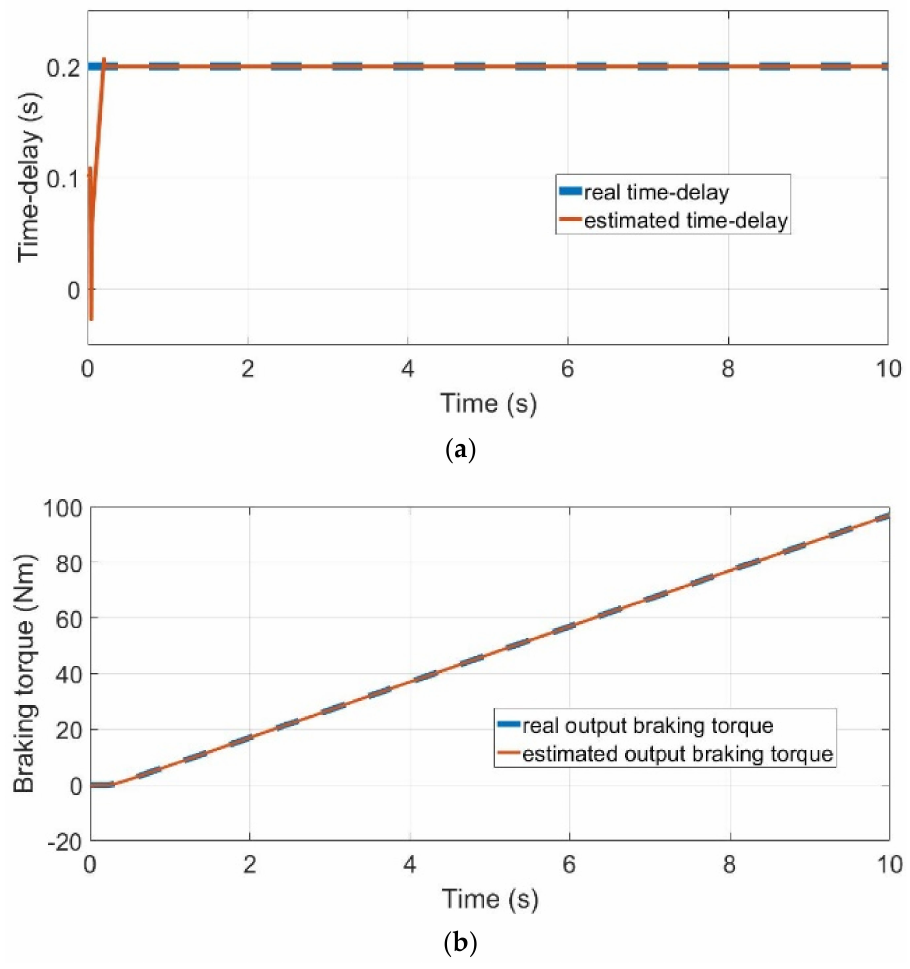
Figure 6. ( a ) Time − delay estimation when the input time-delay is constant. ( b ) Braking torque estimation when the input time-delay is